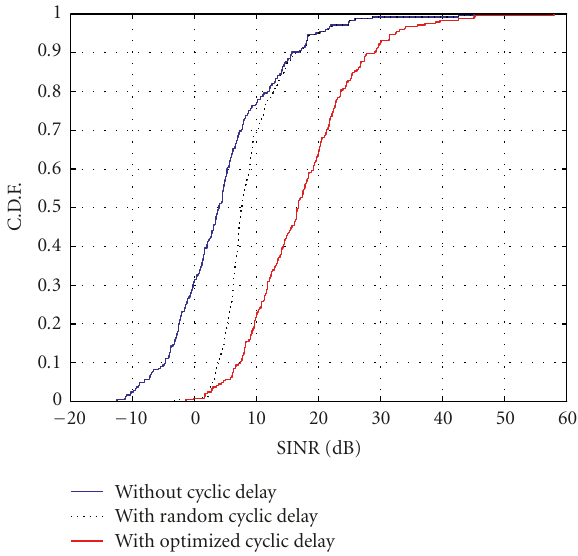
Figure 13: Cumulative distribution function of the received SINR on a rural environment with a cell radius of